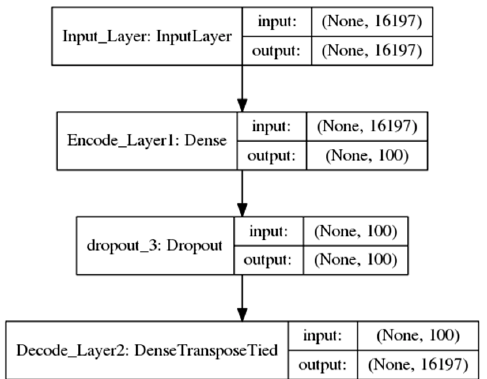
Figure 2. The one-input denoising autoencoders model. There are two hidden layers in the encode phase and two decode layers. The input can be either gene expression data or copy number alteration data.